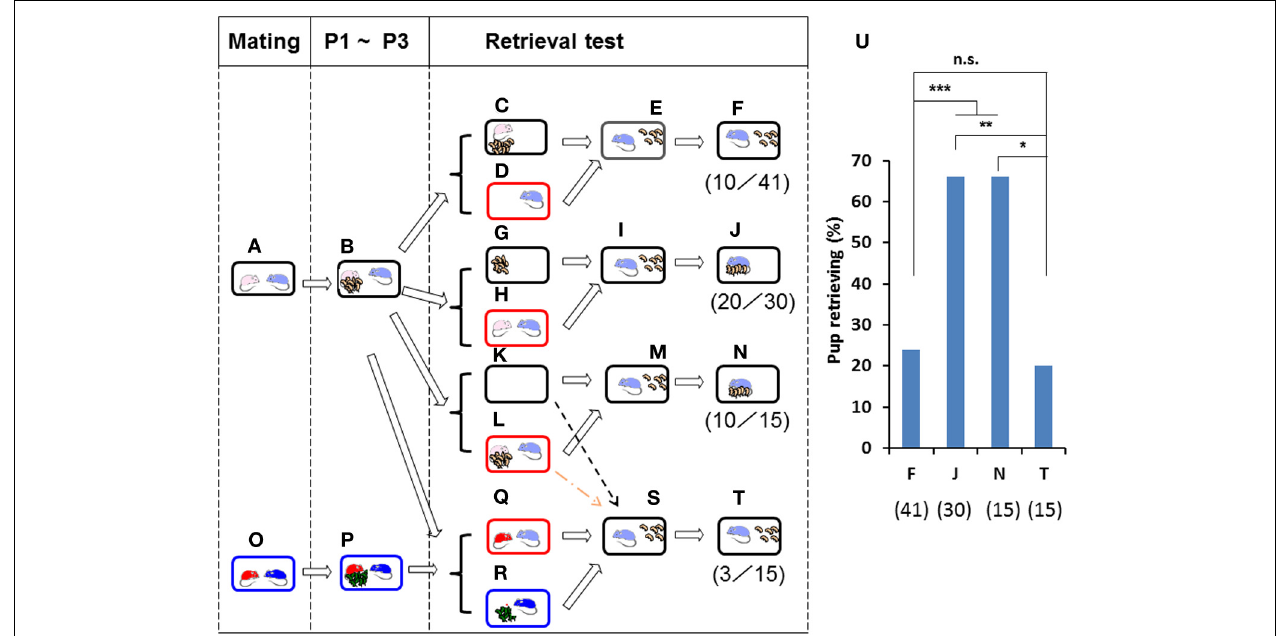
FIGURE 2 | Paternal retrieval test in ICR mice isolated in new cages. Paired couples were kept in rearing cages from mating to postnatal day 3 (P3) (A,B,O,P) . In (C,D) , the pups and the mating dam were left in their home cages (C) , and the sire alone was placed in a new holding cage (D) . In (G,H) , the pups were kept in the original cage, and the parents were placed in a new cage (H) . In (K,L) , the whole family was moved to a new cage (L) . In (Q,R) , the sire was kept during the separation period (Q) with a non-mating dam of another family (O,P) . After isolation for 10min in each cage, pup retrieval behavior over a